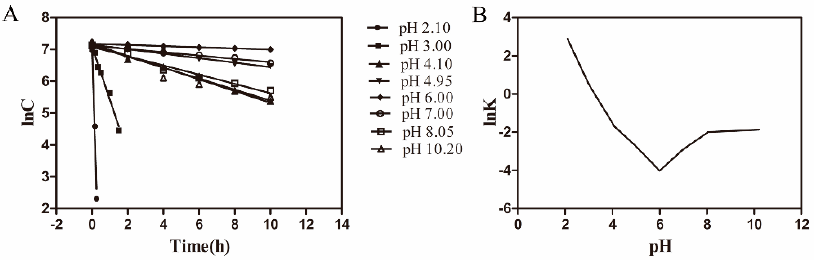
Figure 1. Degradation kinetics of azithromycin. A : Apparent first-order plot of azithromycin (AZI) hydrolysis at various pH values. Temperature was 75 ◦ C and ionic strength ( I ) = 0.3. B : the hydrolysis of AZI at various pH, 75 ◦ C and I = 0.3. Table 1. Rate constants ( K ) for the degradation of AZI in aqueous solution at di ff erent pH values (1–10).